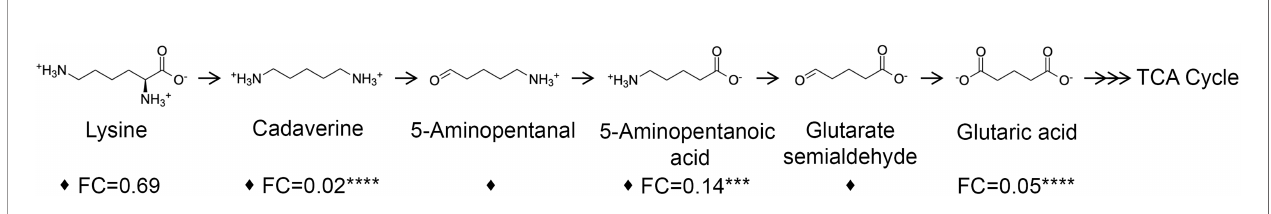
FIGURE 4 | Metabolites of the cadaverine branch of the lysine degradation pathway are signi fi cantly down-regulated in bio fi lm compared to planktonic cultures. Lysine is degraded to supplement the TCA cycle to increase cellular respiration. Metabolites identi fi ed and quanti fi ed by NMR show a fold change (FC) (bio fi lm/ planktonic) (n=9) and asterisks denote signi fi cance (*** p < 0.001, **** p < 0.0001 by unpaired, two-tailed t -test). Metabolites with at least one common adduct detected by mass spectrometry by direct injection in positive ion mode with a mass error of <0.77 ppm are denoted by a black diamond (